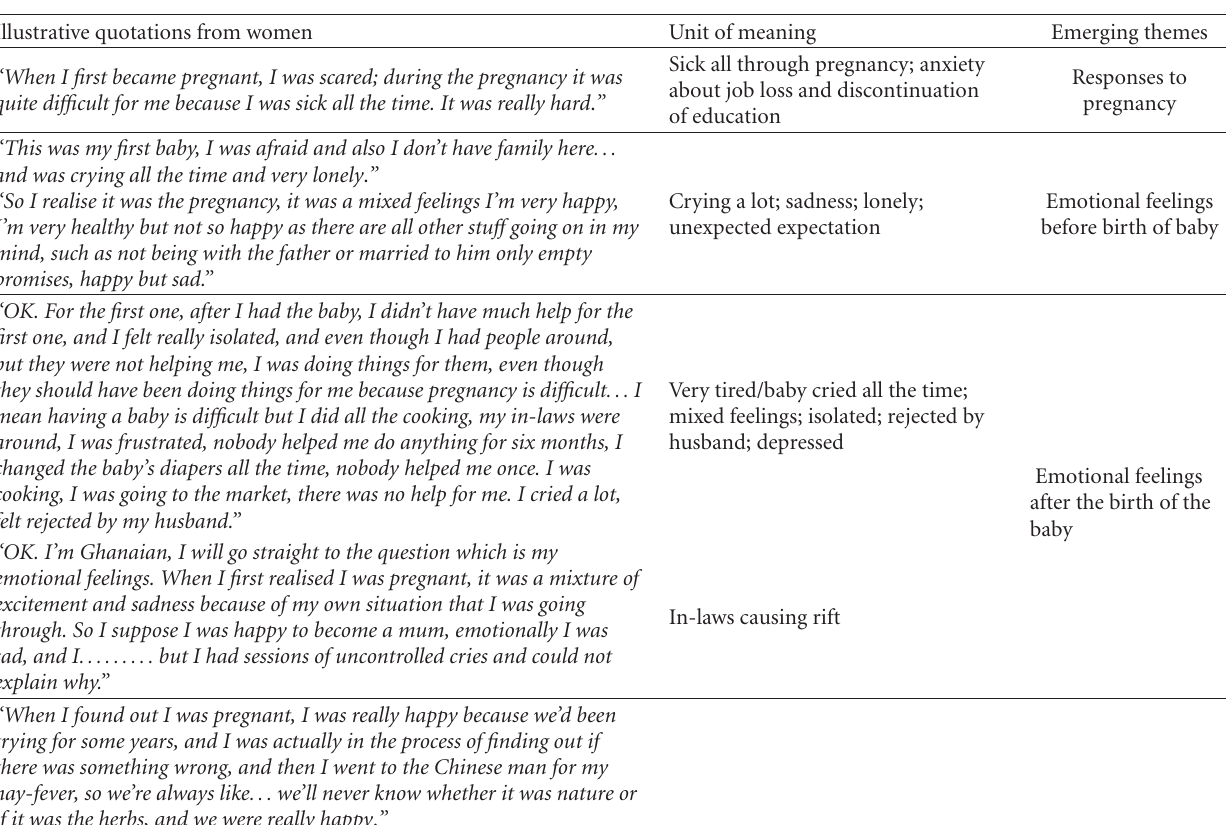
Table 2: Themes arising from data